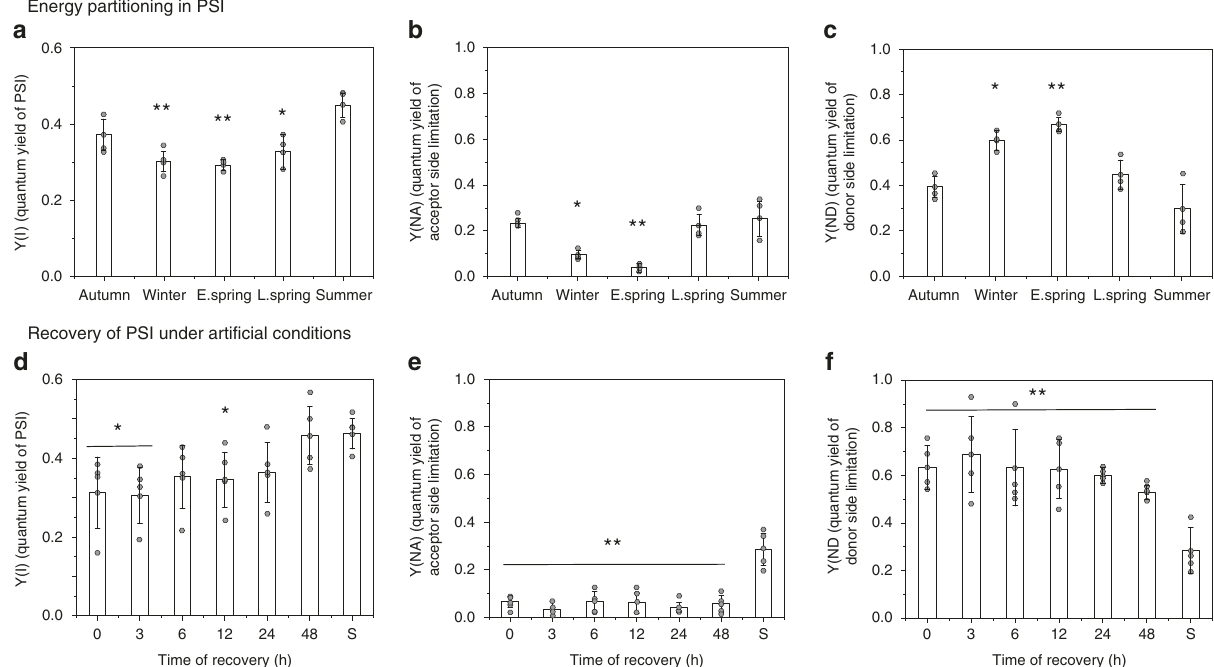
Fig. 2 Seasonal changes of PSI photochemistry in Scots pine needles. Energy partitioning in PSI considering Y(I) + Y(ND) + Y(NA) = 1, where Y(I) ( a ), Y (NA) ( b ), Y(ND) ( c ) are the photochemical quantum yield of PSI (when P700 is reduced and A is oxidized), energy dissipation in PSI (a measure of acceptor side limitation, when P700 and A both are reduced) and energy dissipation in PSI (a measure of donor side limitation, when P700 and A both are oxidized), respectively. Recovery of PSI photochemistry under arti fi cial conditions: ( d ) Y(I), ( e ) Y(NA), ( f ) Y(ND) of PSI during the recovery period. Quantum yields were calculated from 300 μ mol m − 2 s − 1 light illumination period of a light response curve. All measurements were taken after 30 min of dark adaptation at 4 °C from winter to late spring and room temperature in summer. Error bars indicate the mean ± SD ( n = 3) for ( a – c ); ± SD ( n = 4) for ( d – f ). The statistically signi fi cant mean differences (t-test) are marked by asterisks indicating the following con fi dence intervals: * ≤ 95%; ** ≤ 99%.; *** ≤ 99.9%. Exact p values are provided in the source data fi